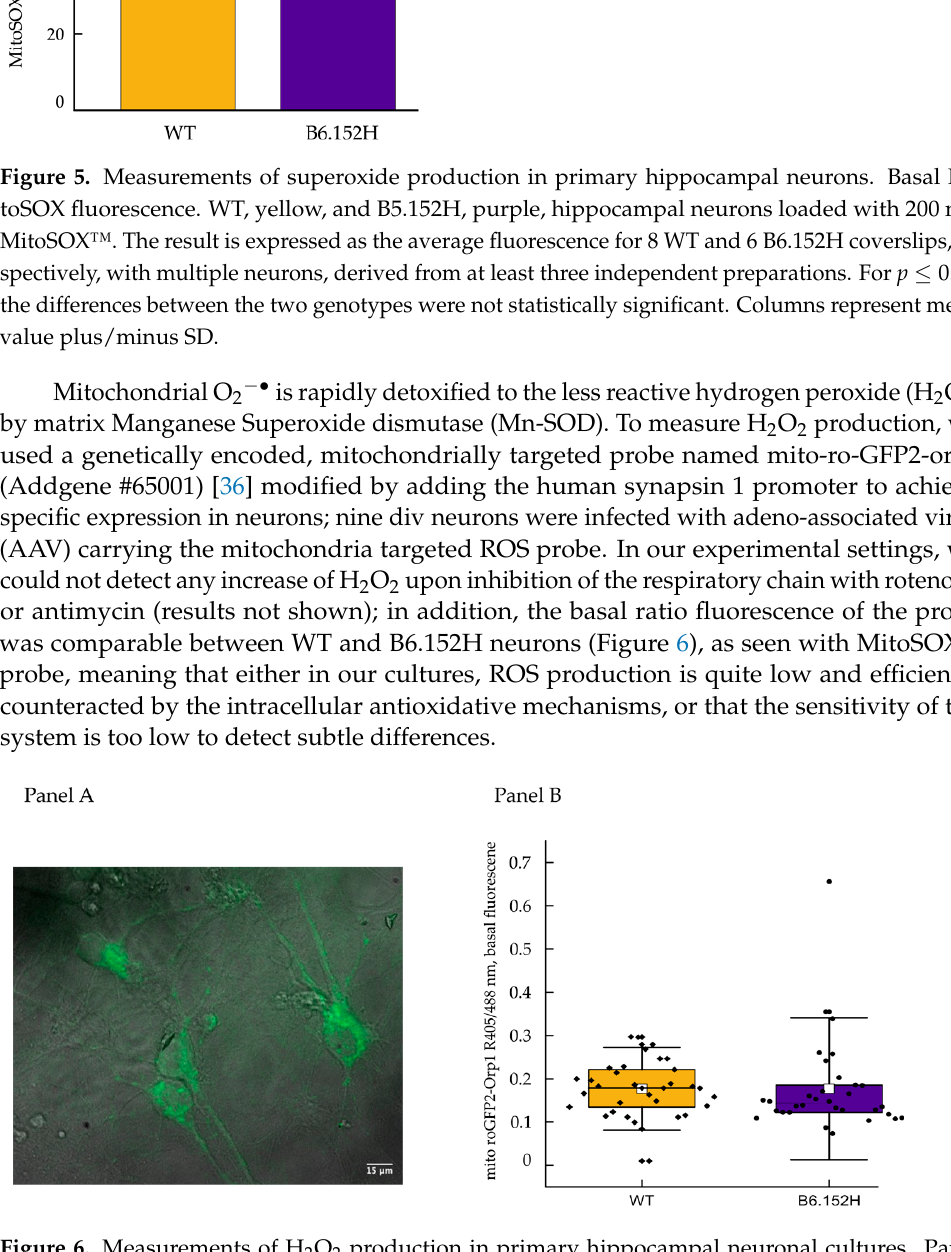
Figure 6. Measurements of H 2 O 2 production in primary hippocampal neuronal cultures. Panel ( A ): Representative image of hippocampal neurons expressing the mitochondrial targeted probe for H 2 O 2 , mito roGFP2-orp1. Fluorescence image recorded illuminating the cells with a 488 nm excita- tion wavelength and superimposed to the corresponding bright field image. Panel ( B ), quantifica- tion of the basal fluorescence of the probe expressed as the ratio between 405 and 488 nm illumina- tions. Symbols represent individual cells obtained from at least three independent preparations for each genotype, WT, n = 34 cells, median = 0.18; B6.152H n = 32 cells, median = 0.14. Box